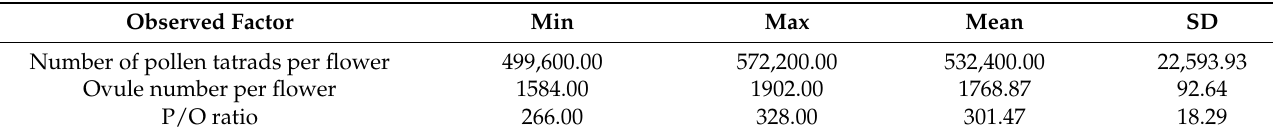
Table 4. Estimation of the P/O ratio of R.